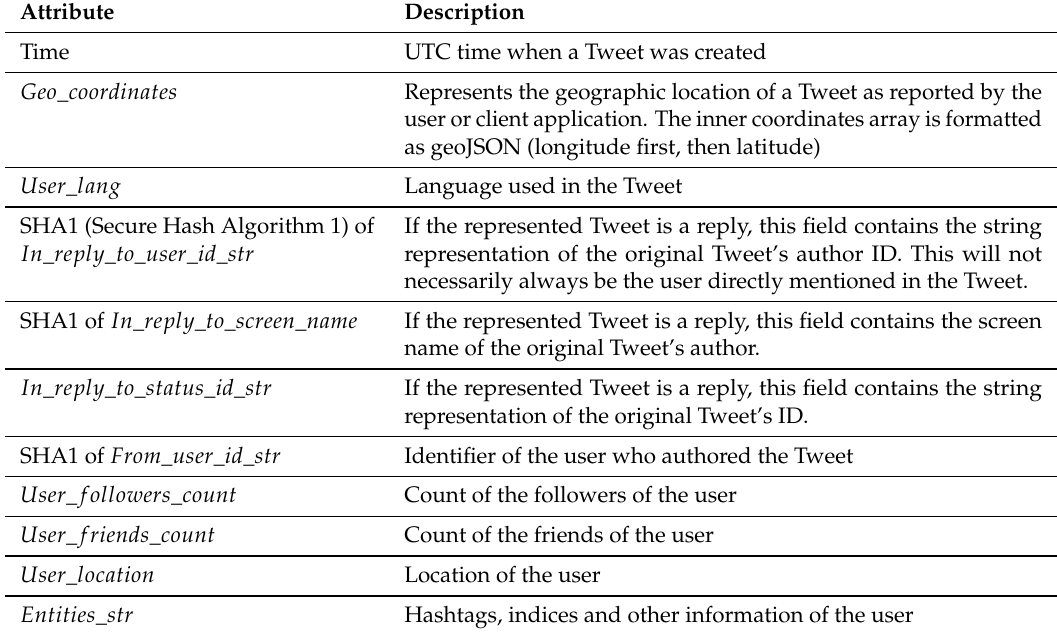
Table 1. Data considered in the